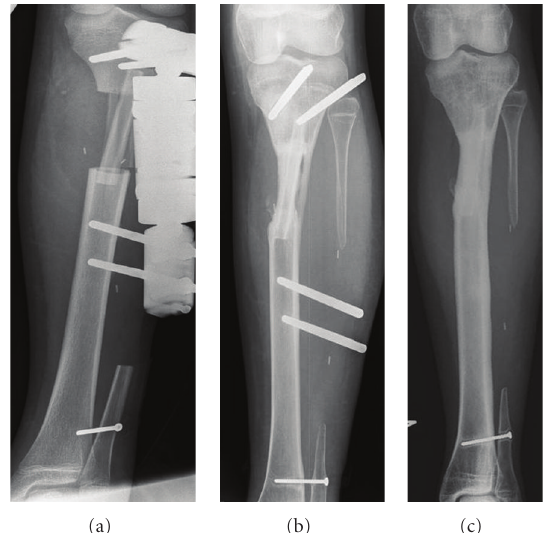
Figure 1: Resection of the proximal part of the tibial diaphysis performed because of an osteosarcoma and reconstruction of the bone defect with a double-barrelled pedicle vascularized fibula graft (patient 7). X-rays taken 9 days postoperatively (a), after 16.5 months when weight bearing without external fixation (fixation pins left until the e ff ect of weight bearing was evaluated) had been started 3 weeks earlier (b), and status 53 months postoperatively